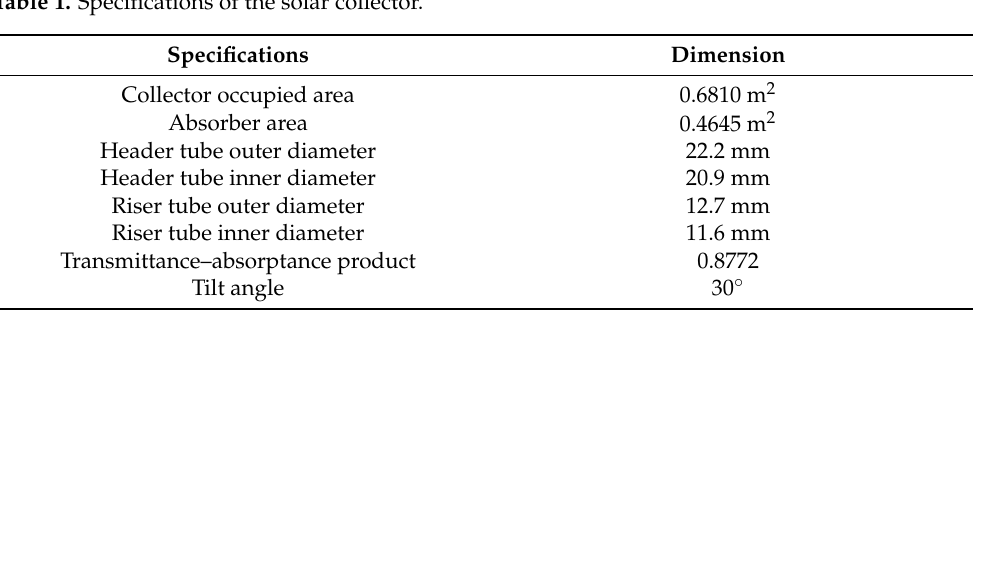
Table 1. Specifications of the solar